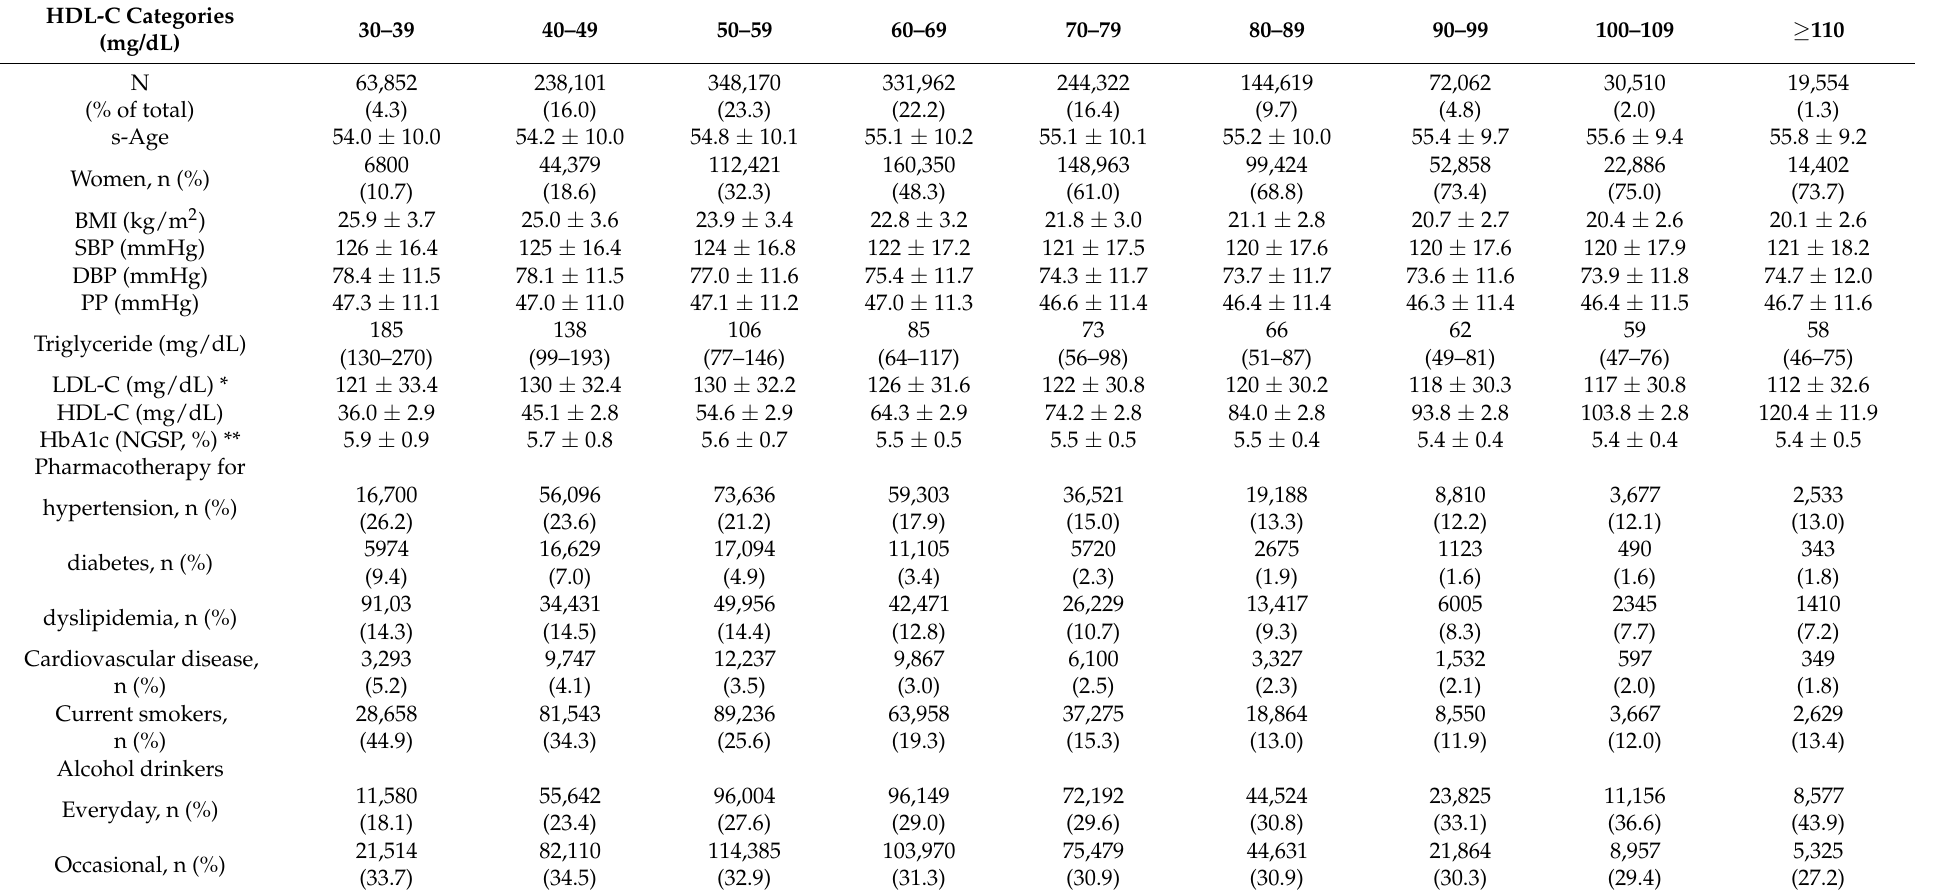
Table 1. Clinical characteristics of